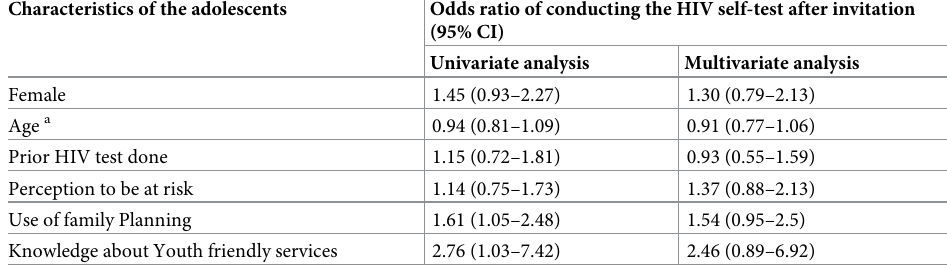
Table 2. Univariate and multivariate analysis of factors associated with attendance for directly assisted oral HIVST post invitation (n = 372).